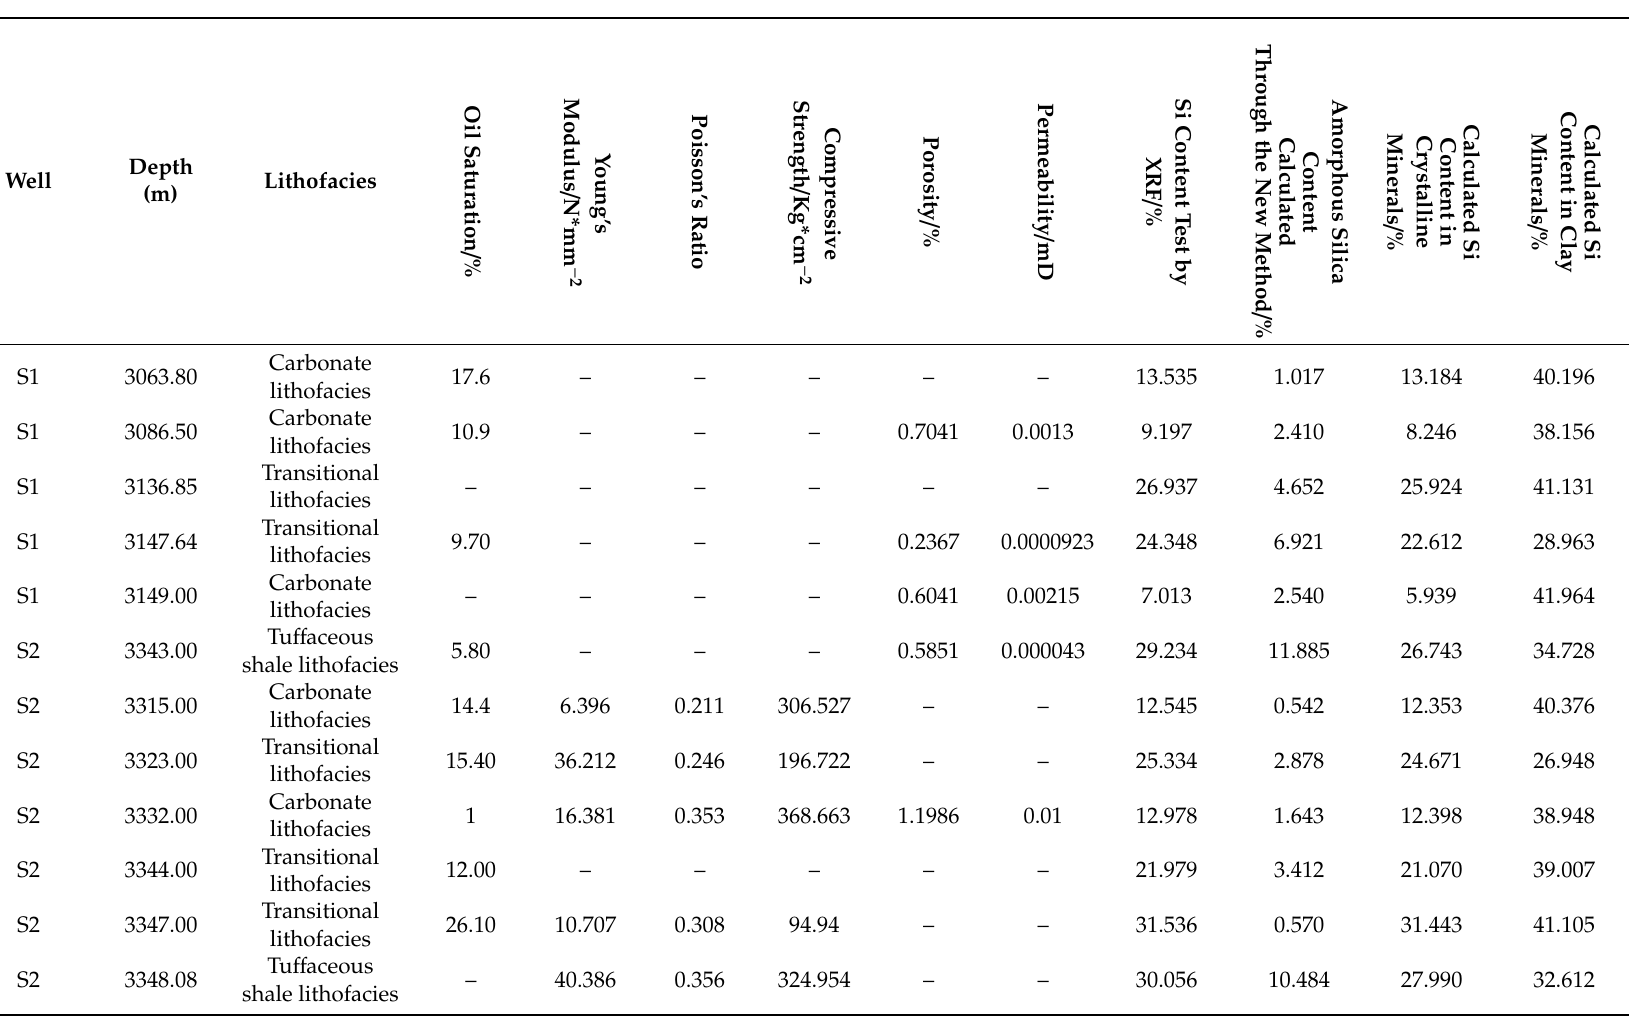
Table 2. Statistical table of calculated silica content, porosity, permeability, mechanical properties, and oil saturation in di ff erent lithofacies samples of the Lucaogou